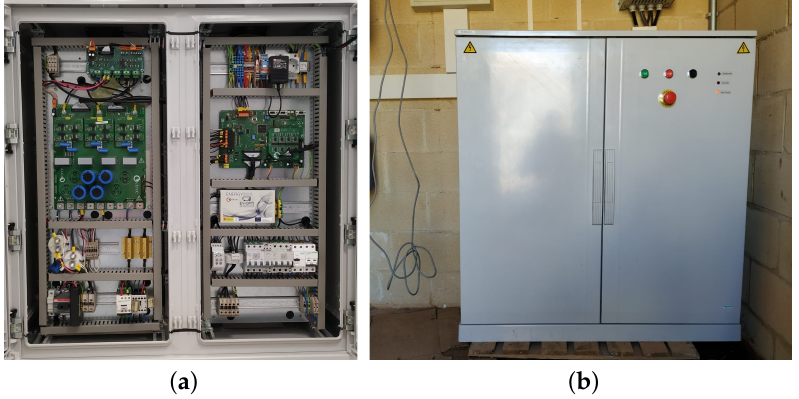
Figure 7. Bidirectional inverter developed for the direct polarization of the panels ( a ), and inverter installed in the demo site facilities ( b